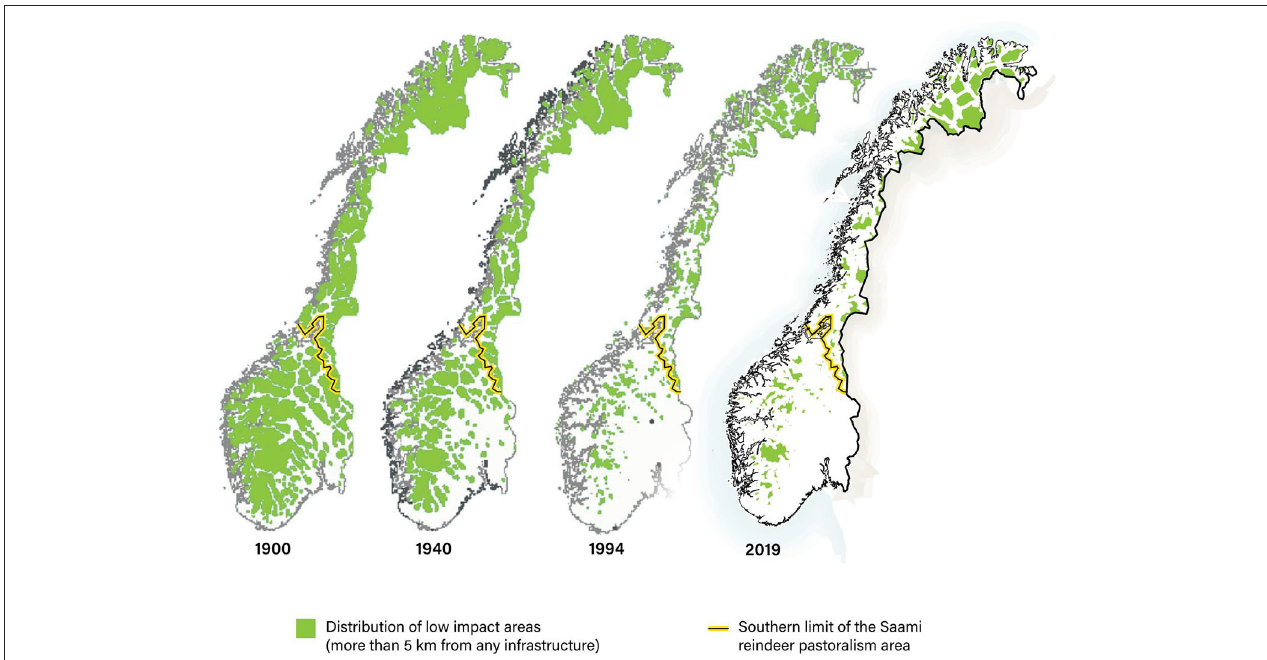
FIGURE 18 | Loss of habitat: distribution of areas of Norway > 5km from any infrastructure (green shading) 1900–2019. The yellow line marks the southern boundary of the Saami reindeer husbandry area (see Figure 3 ). Sources: Nellemann et al. (2003), Norwegian Mapping